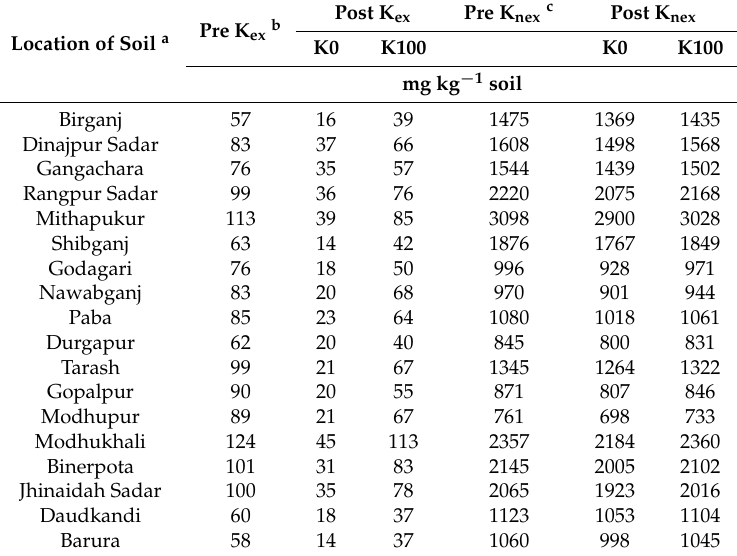
Figure 7. The relationship between exchangeable soil K (K ex ) and K uptake ( a . after first harvest and b . after seventh harvest), and between non-exchangeable K (K ex ) for 18 diverse soils of Bangladesh and K uptake ( c . after first harvest and d . after seventh harvest) in the above ground biomass of rabi maize grown up to V10–V12 in pot as successive crop. Table 4. Amount of exchangeable and non-exchangeable K before the start of the experiment (initial) and after seventh harvest (grown up to V10–V12) of maize grown in pots with K 0 and K 100 with 18 diverse soils, Gazipur, Bangladesh.